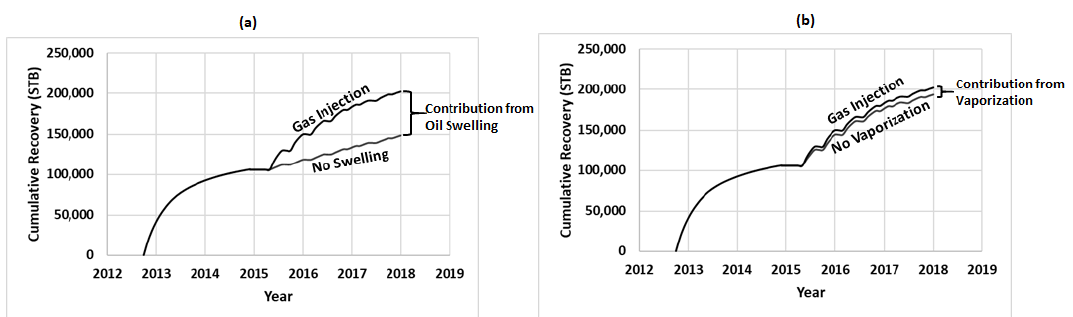
Figure 13. A different method to find the contribution of ( a ) oil swelling and ( b ) vaporization. Figure 13. A di ff erent method to find the contribution of ( a ) oil swelling and ( b )